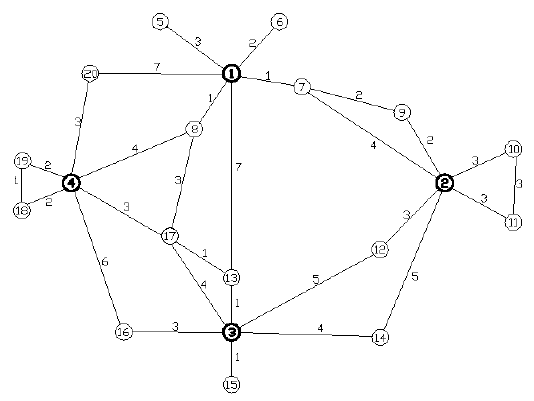
Figure 2. Topological graph of an emergency logistics network in a region.